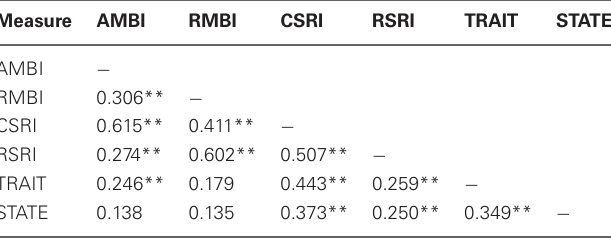
Table 2 | Relationship of self-report measures of anxiety